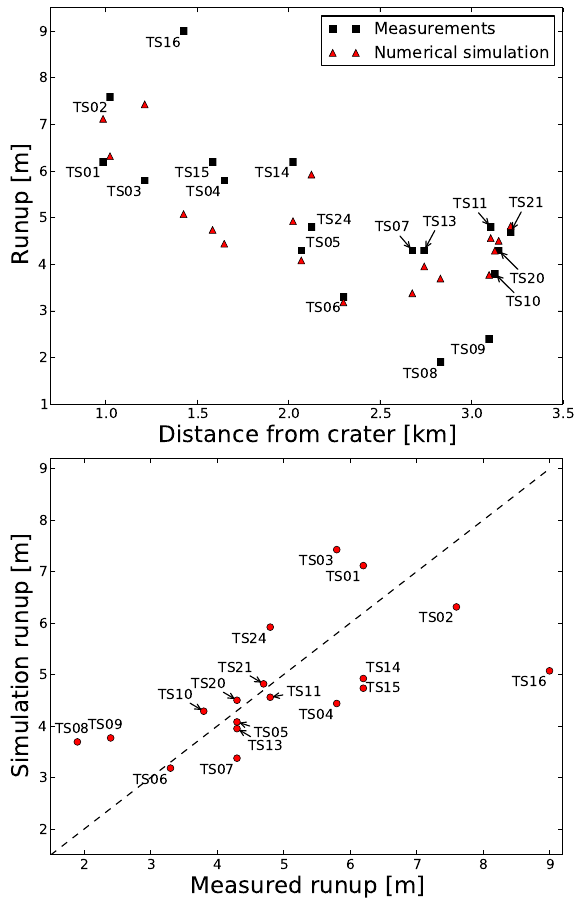
Fig. 5. Comparison of measured and simulated run-ups around the Karymskoye lake. Results are for simulation with η 0 = 55m and no bottom friction. (Top) Run-up as a function of distance from crater. (Bottom) Simulated run-up as a function of the measured run-up at 18 different locations. The dashed line corresponds to the simulated run-ups equal to the measured values.